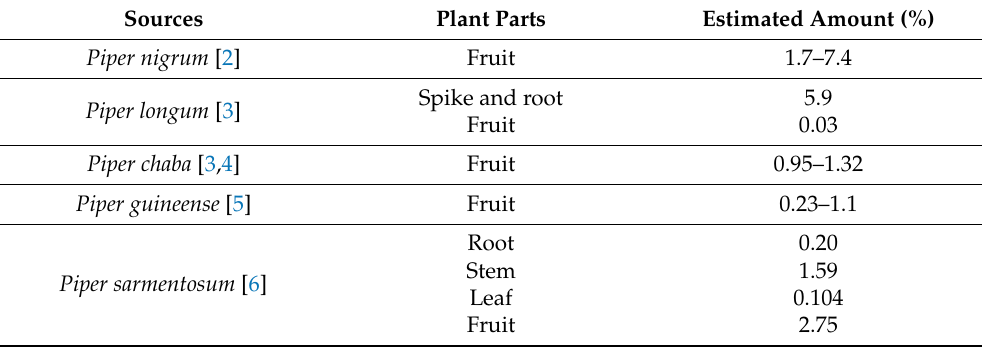
Table 1. Estimated amounts of PIP in different plant